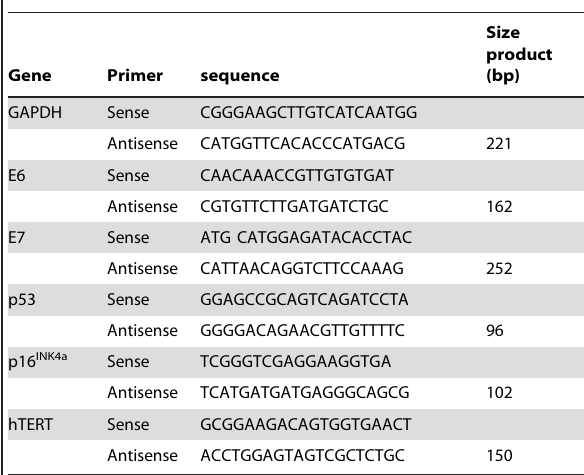
Table 1. Primers used in this